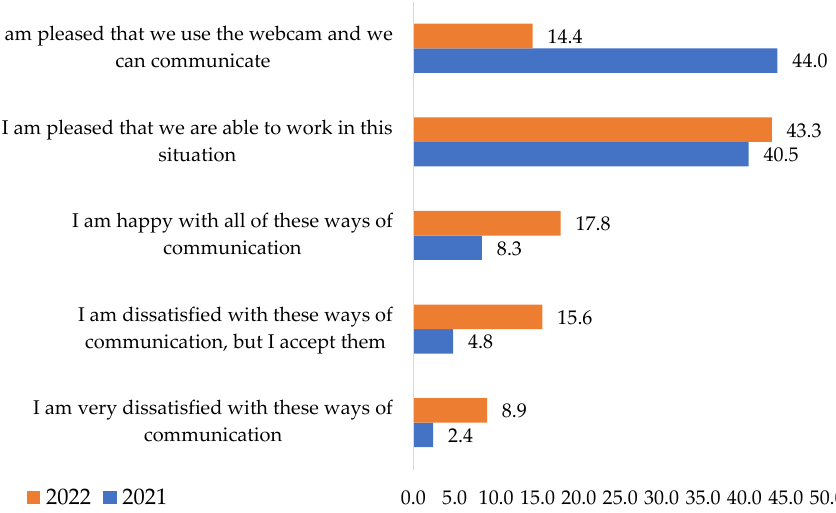
Table 4. Chi-square tests for the elements that meet the expectations with online communication in relationships with colleagues (e.g., Microsoft Teams, Skype, etc.).